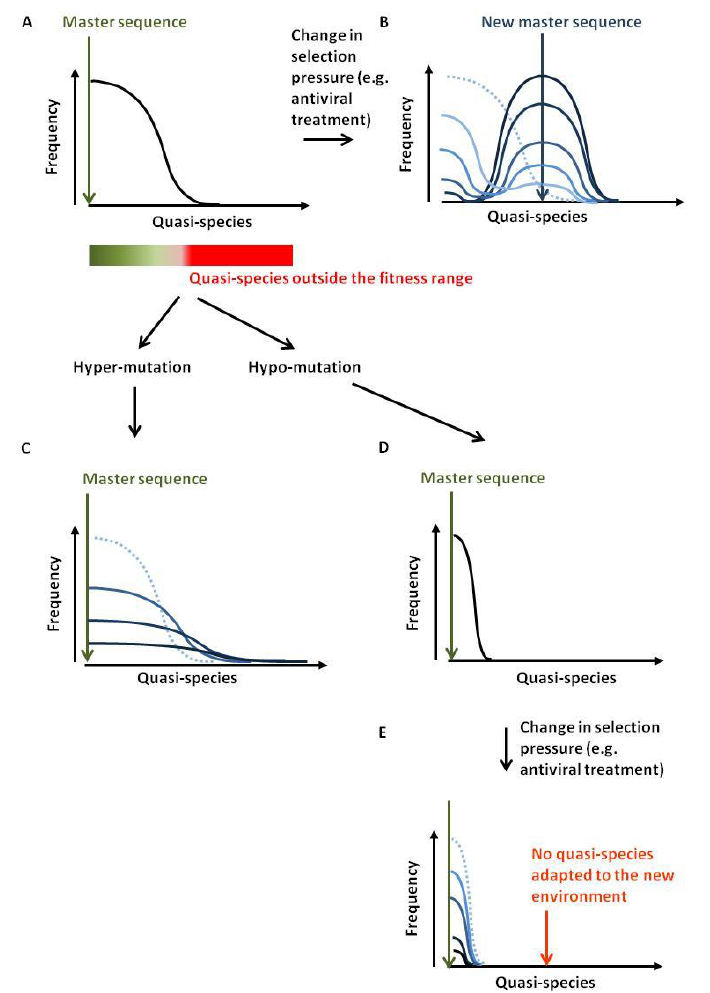
Figure 7. Antiviral strategy by hypo- or hyper-mutation. ( A ) Viral quasi-species refer to as a population of distinct but closely related viral genomes that only differ by a limited number of mutations. The frequency of these quasi-species spreads around a master se- quence. The boundary of this population is dictated by the selection forces acting against the viral diversification. At equilibrium, quasi-species generated outside the fitness range will not persist. ( B ) If selection criteria are modified, the fittest sequence will change. If the